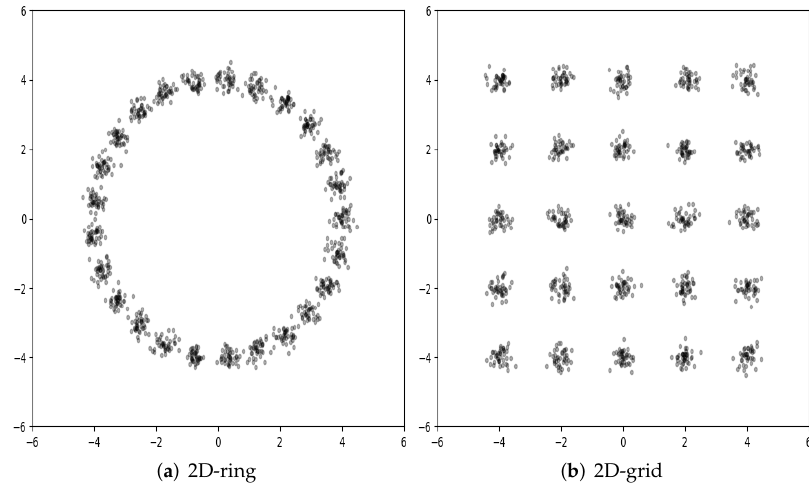
Figure 3. Toy datasets. Table 1. Experiments on synthetic datasets under standard benchmark settings, in which we can not capture more data modes, but also improve the sample quality. We adopt the vanilla GAN model to train ours 1 , and the CTGAN to train ours 2 , respectively. The best score is marked in bold. 2D-Ring 2D-Grid Modes h-Quality Reverse Modes h-Quality Reverse Max 25 Samples